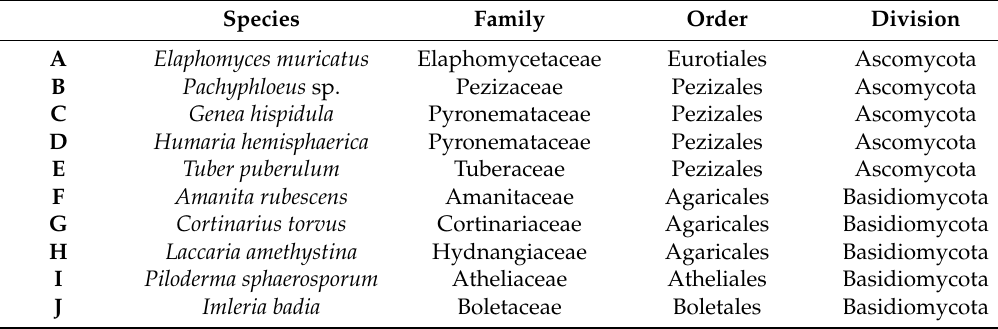
Table 1. Fungal taxa used for the study. Letters in the first column ( A – T ) were assigned to the taxa for further